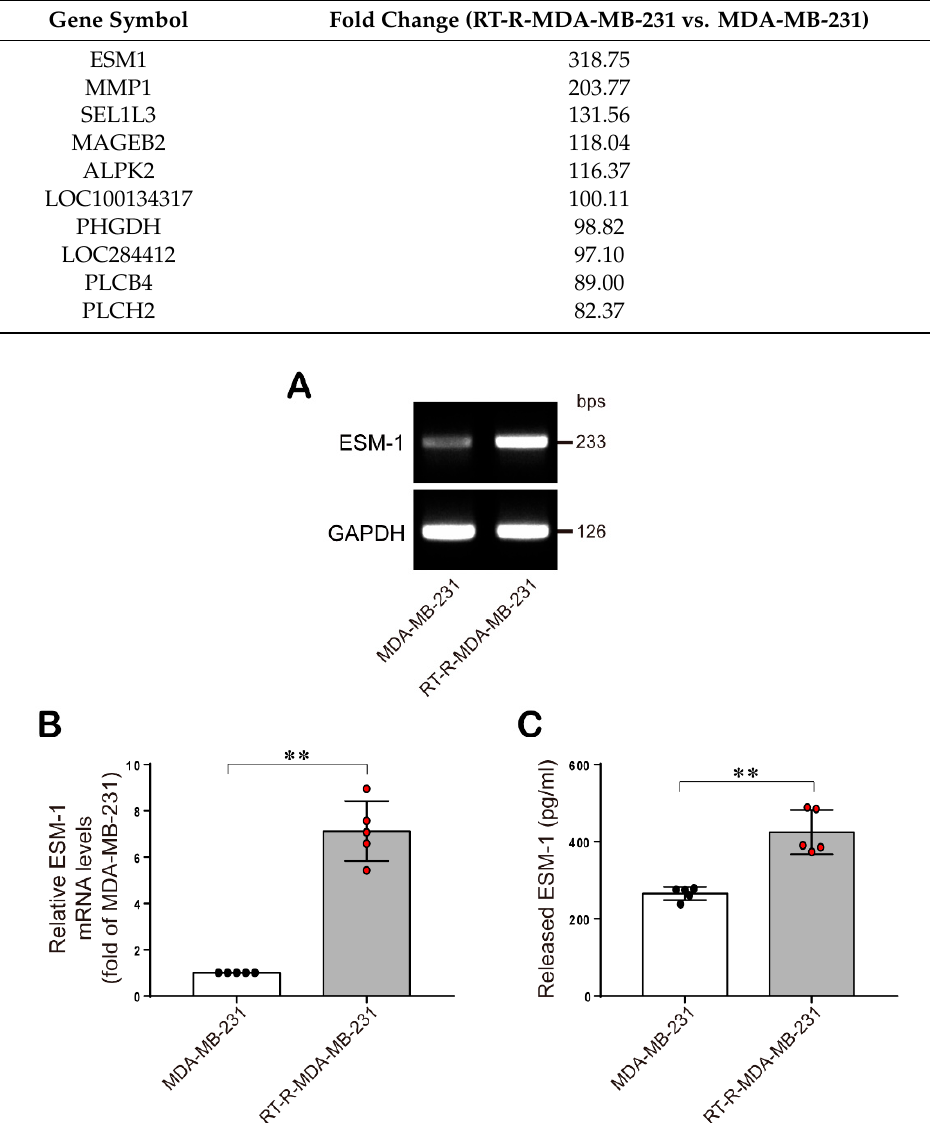
Figure 1. ESM-1 expression levels in MDA-MB-231 cells and their RT-R derivatives. ( A , B ) ESM-1 mRNA expression in RT-R-MDA-MB-231 cells and their parental cells, MDA-MB-231 was analyzed by RT-PCR. The full blot image can be found in Figure S1. Representative ESM-1 mRNA levels ( A ) and the quantification of ESM-1 mRNA levels ( B ) in MDA-MB-231 and RT-R-MDA-MB-231 cells. The data represent the mean ± SD of five independent experiments. ( C ) Cells were incubated for 72 h, and the levels of ESM-1 secreted by MDA-MB-231 and RT-R-MDA-MB-231 cells into cell culture medium were measured using ELISA kit for ESM-1 as described in the methods sections. The data represent the mean ± SD of five independent experiments. * p < 0.05, ** p < 0.01.